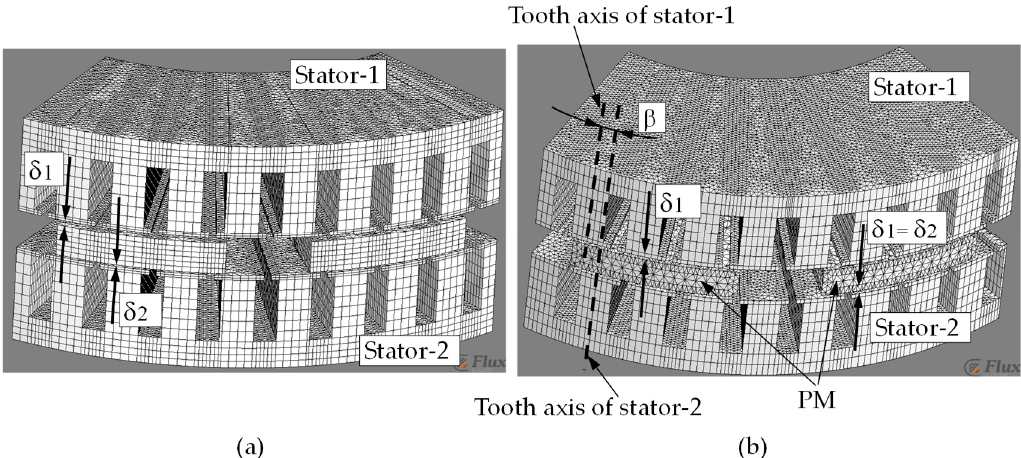
Figure 9. Representation of 3-D FE models (air regions, non conducting area and winding set are invisible) with a selected mesh size. Two di ff erent misalignment e ff ects were investigated: ( a ) Rotor misalignment; ( b ) stator